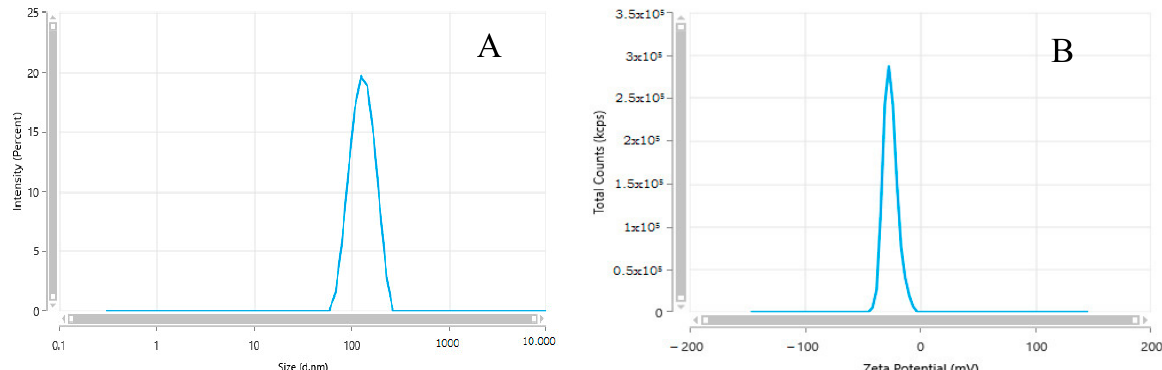
Figure 1. Representative hydrodynamic size ( A ) and Zeta potential ( B ) of the SiNP suspension.